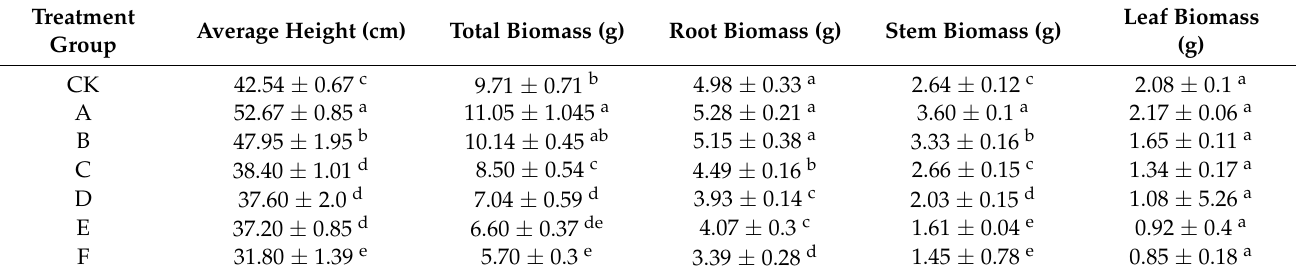
Table 1. Effect of Pb stress on growth parameters of K. paniculata